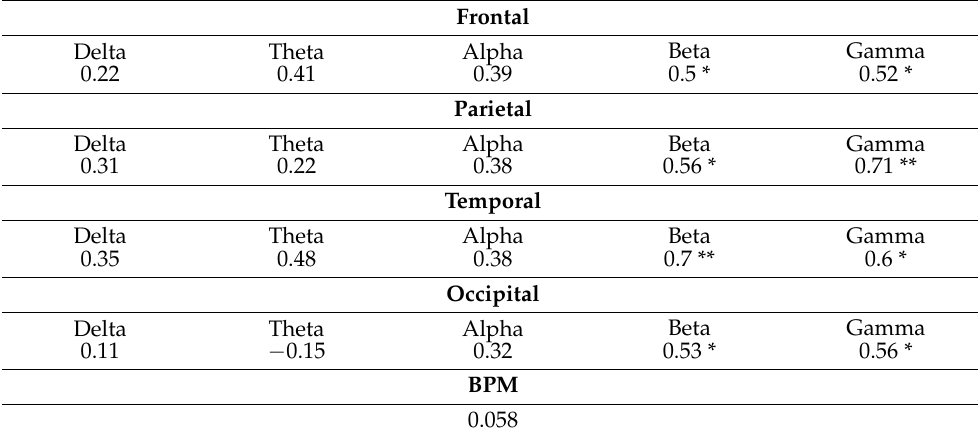
Table 5. Spearman Correlation of the alteration of each power band and the alteration of the BPM with the PSS score. The symbol * indicates high correlation ( ≥ 0.5). The symbol ** indicates correlation ≥